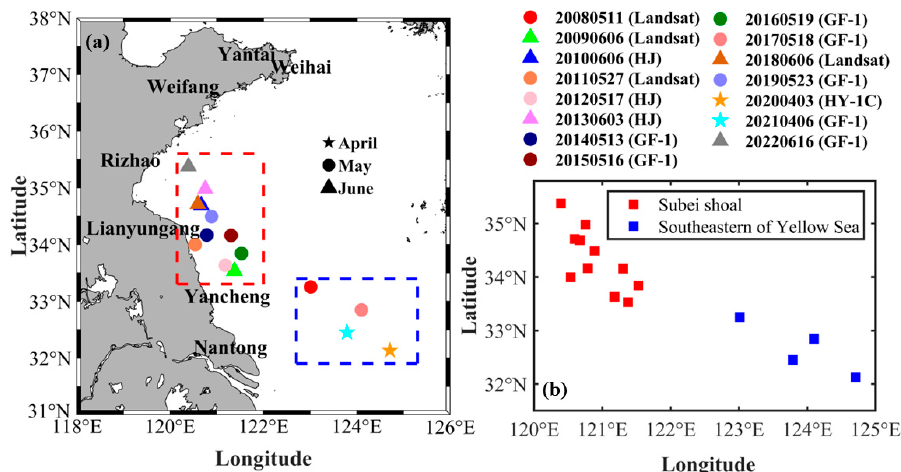
Figure 15. Source site statistics 2008–2022. ( a ) shows the source sites of green tide blooms over the years, and ( b ) shows the results of k-means clustering, which divided the green tide source into two clusters: the Subei shoal (red box) and the southeastern Yellow Sea (blue box).